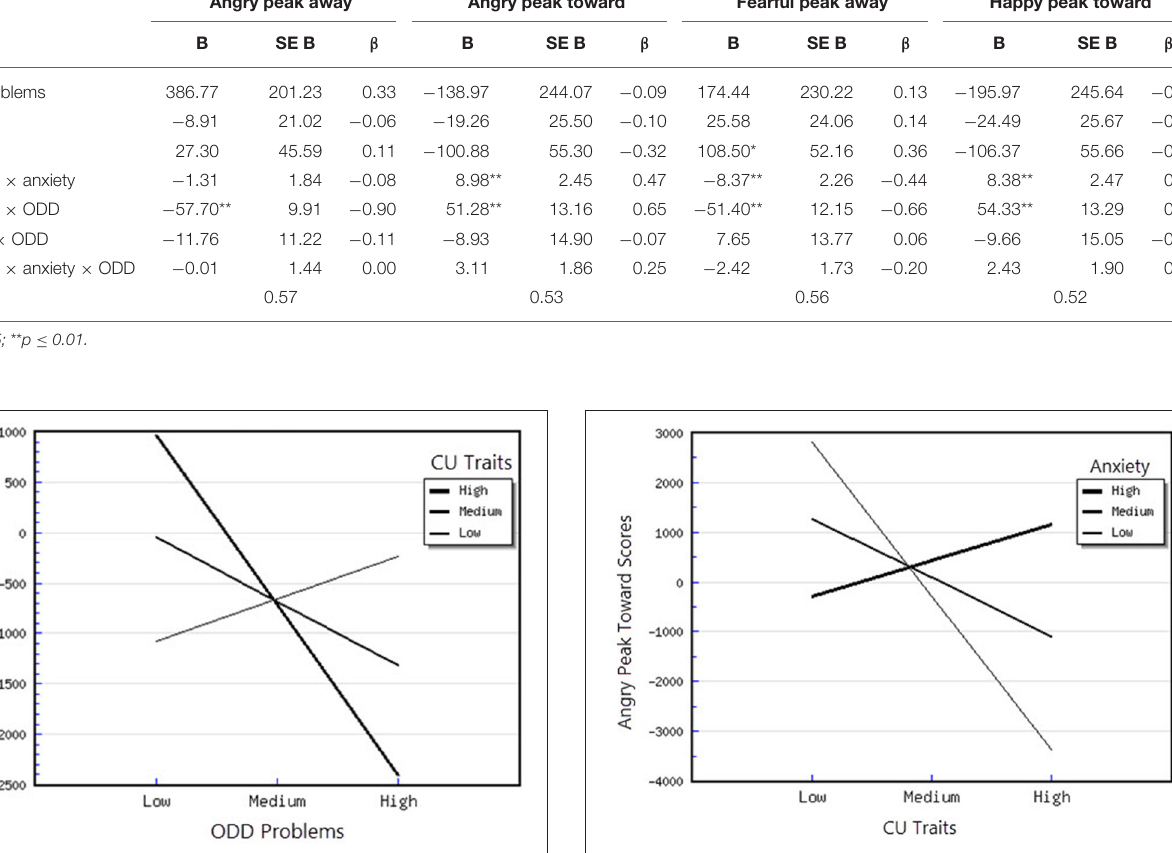
or away from emotional faces—Peak Toward, respectively Peak Away) varied, based on the interactions between